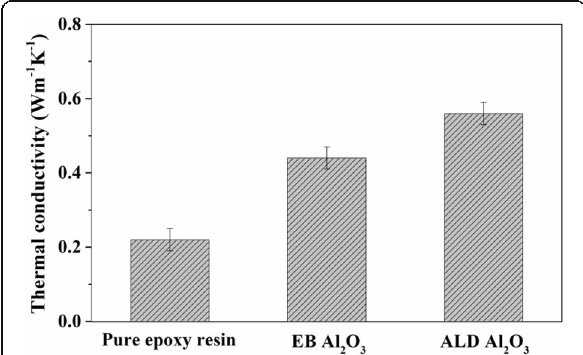
Fig. 9 Thermal conductivity analysis of different films: the film with pure epoxy resin and the composite films with VACNTs grown on EB and ALD Al 2 O